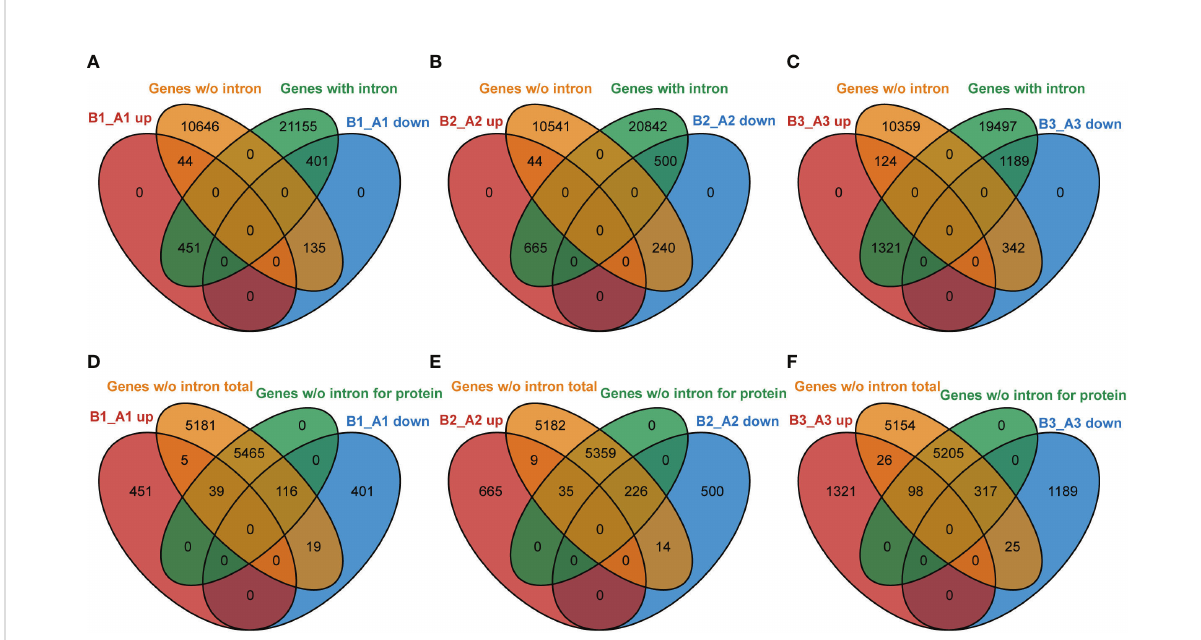
FIGURE 9 NTR1 shows a preference for impeding the expression of intron-containing genes. (A – C) Venn diagrams of common genes between DEGs of hl761 mutants vs. the control plants (CK) before heat treatment (A) , and 15-min (B) and 60-min (C) heat treatment and intron-containing genes or that without intron. (D – F) Venn diagrams of common genes between DEGs of hl761 mutants vs. the control plants (CK) before heat treatment (D) , and 15-min (E) and 60-min (F) heat treatment and total genes without intron or subset protein-coding genes. DEGs, differentially expressed